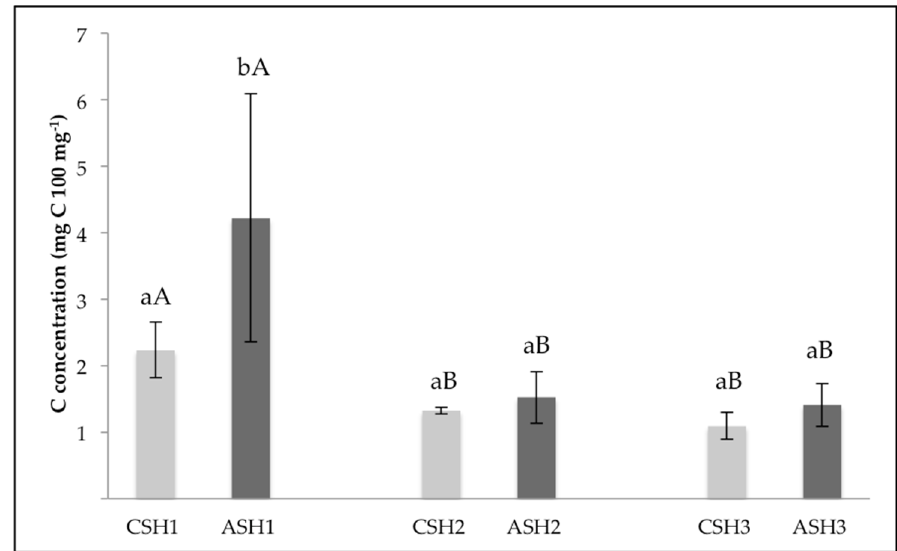
Figure 5. Values of C concentration (mg C 100 mg − 1 ) in each horizon (H1: 0–10 cm; H2: 10–20 cm; H3: 20–30 cm) of cultivated soils (CS) and abandoned soils (AS). Different small letters indicate significant differences between the same horizon of different land use (Student’s t -test for paired samples, p < 0.05). Different capital letters indicate significant differences between different horizons with the same land use (ANOVA test, p < 0.05).